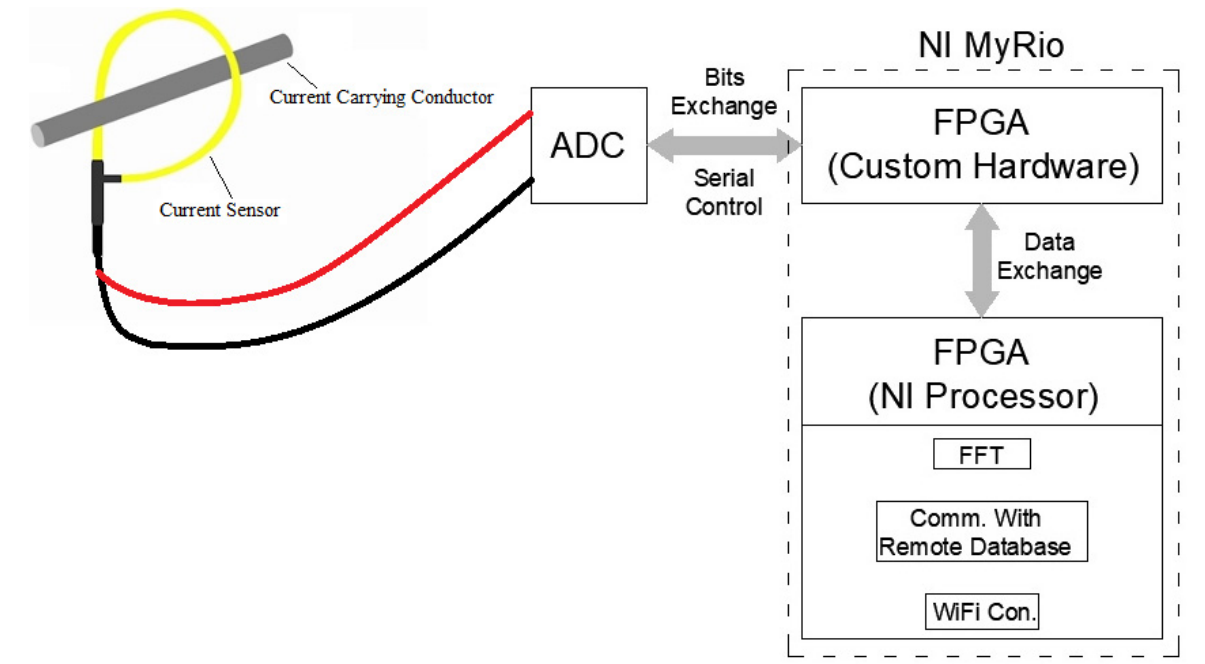
Figure 13. Proposed and implemented measuring system using the MyRio device and external ADC.